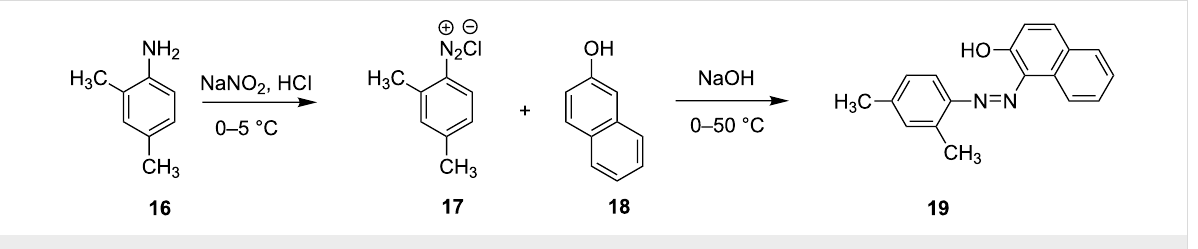
Scheme 6: Continuous flow synthesis of Sudan II azo dye in LTF-MS microreactors.